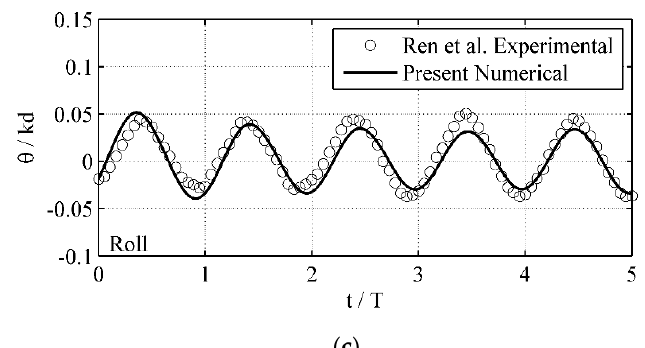
Figure 3. The time sequences of the motions of the floating box under regular waves ( H = 0.04 m); ( a ): heave; ( b ): sway; ( c ): roll.